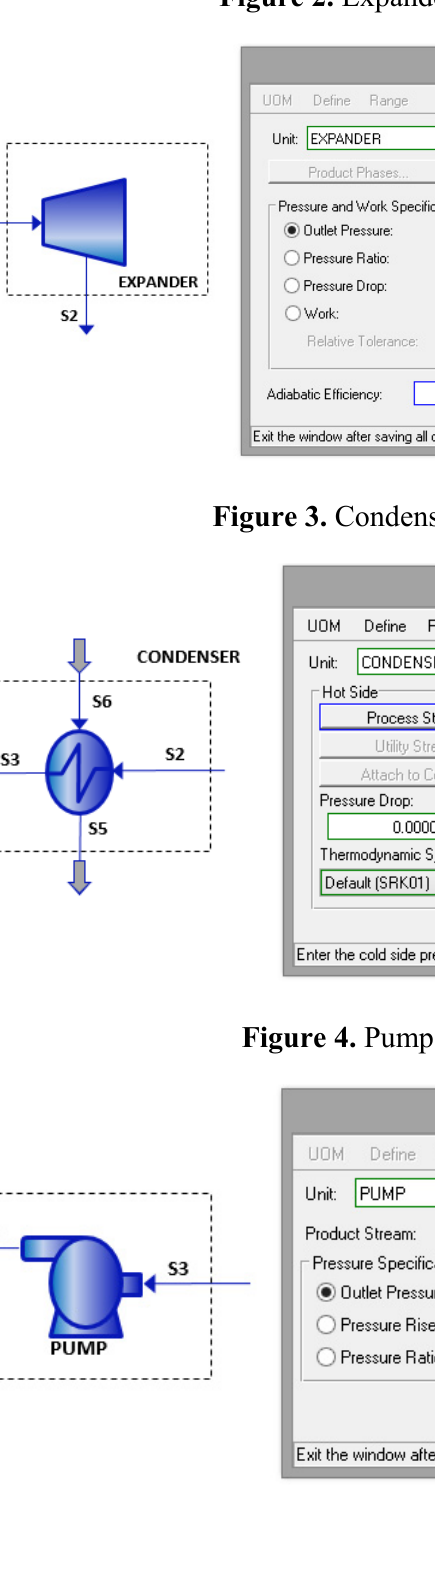
Figure 2. Expander properties selection.